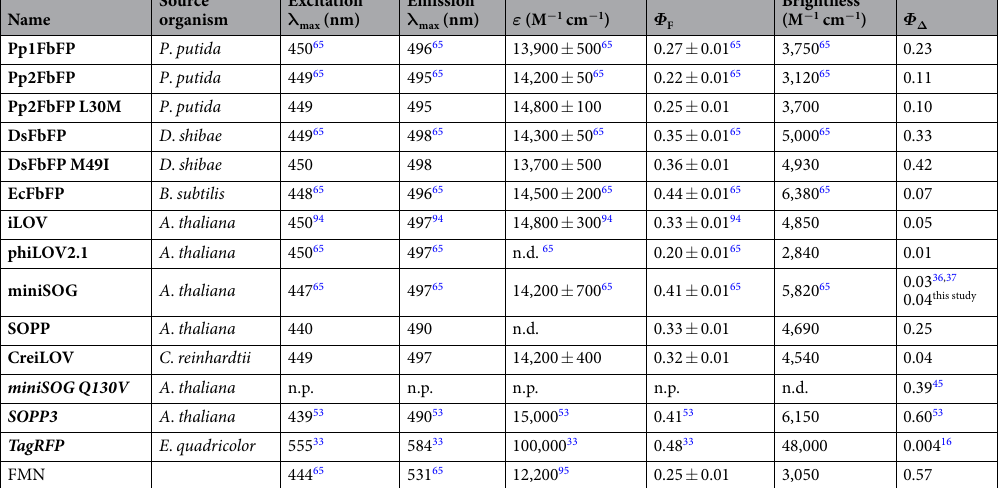
Table 1. Singlet oxygen quantum yields ( Φ Δ ) and photophysical properties of LOV- and GFP-based photosensitizers. Extinction coefficient ( ε ) and fluorescence quantum yield ( Φ F ) of LOV-based PS that were analyzed in this study (highlighted in bold) are given as mean values with standard deviations determined from three independent measurements. The fluorescence brightness is the product of individual ε and Φ F values. The extinction coefficient as well as the brightness of phiLOV2.1 and SOPP could not be determined directly (n.d.), as both proteins aggregated at 95 °C. Therefore, for further calculations, an average extinction coefficient of 14,200 M − 1 cm − 1 was assumed for these variants. For a better comparability, values of miniSOG Q103V, SOPP3 and TagRFP (marked in bold and italic) that have been obtained from indicated publications were also listed; n.p.: not published.